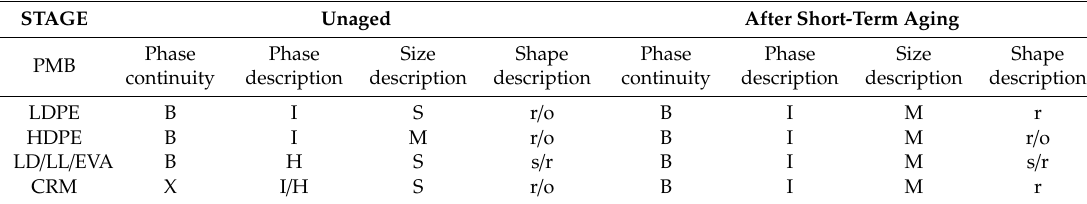
Table 11. Morphological characterization of the PMBs